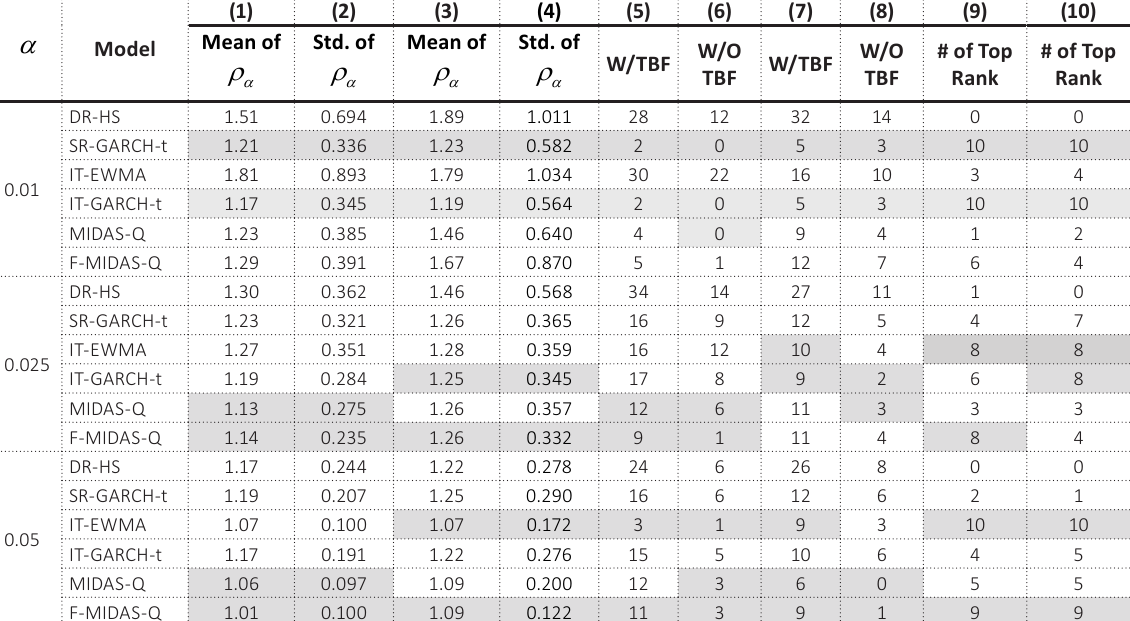
Table 1. Summary of testing results for the out-of-sample 5-step and 10-step VaR forecasts